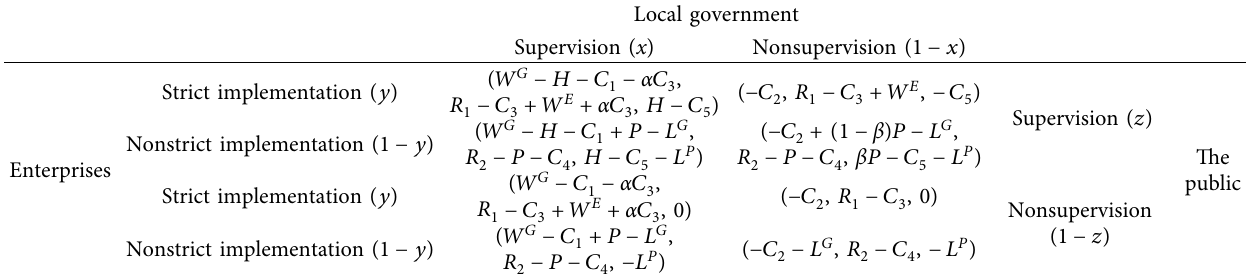
Table 2: The payoff matrix of the